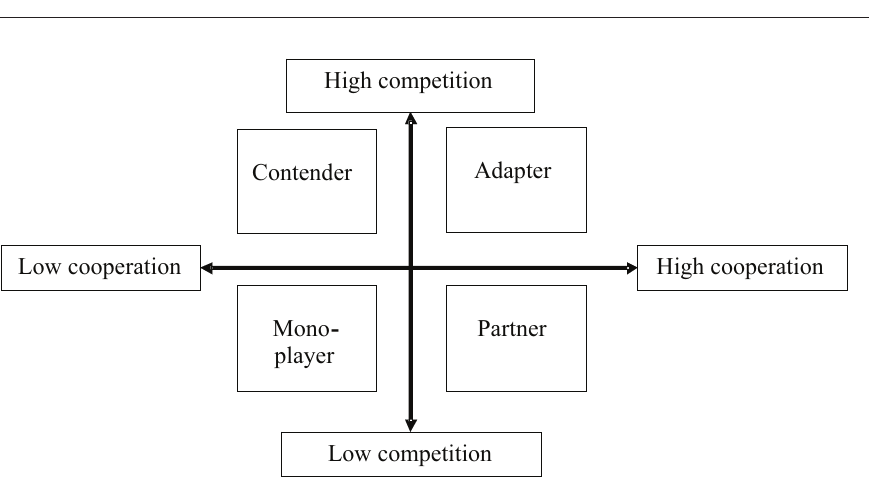
Figure 2. A typology of coo- petition proposed by Y.